Question: Author a descriptive caption for the visualization shown.
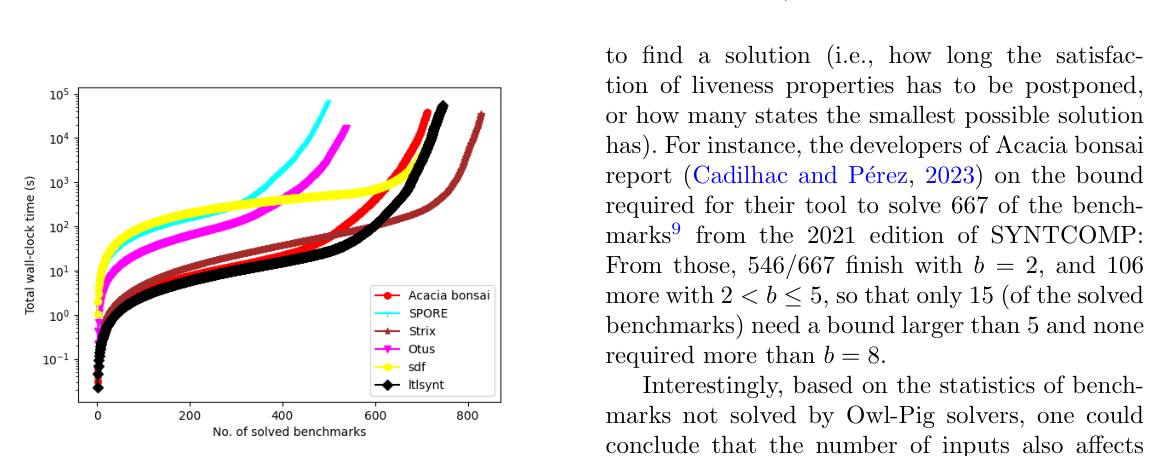
Answer: Cactus (a.k.a. survival) plots for the participants of the LTL realizability track of SYNTCOMP 2021; Note that the y-axis is displayed using logarithmic scale